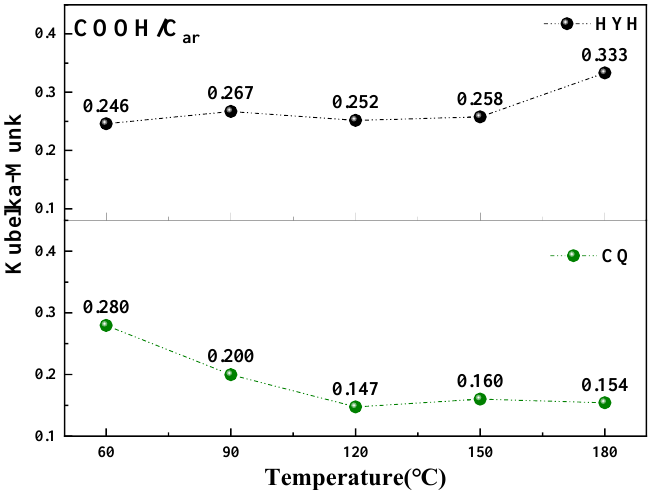
Figure 15. Variations in COOH functional groups in HYH and CQ coal samples.